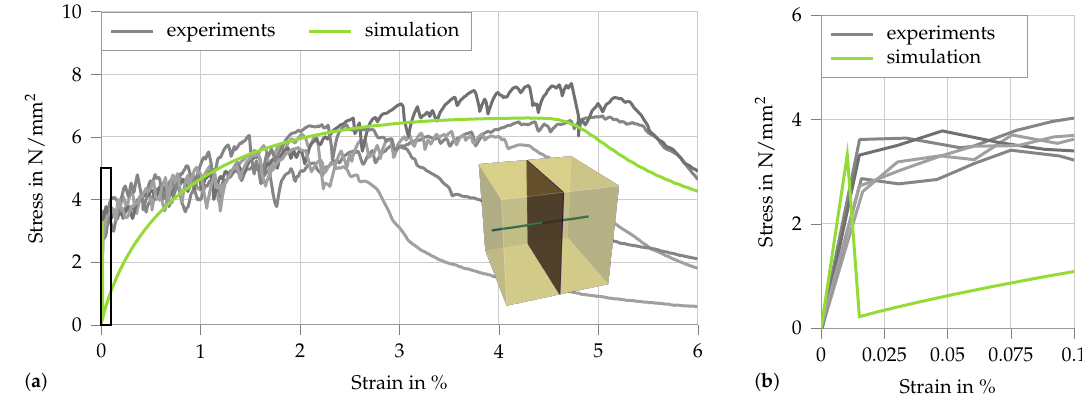
Figure 8. Results of the quasi-static multiscale simulation compared to the experimental data from [5,27]: ( a ) the loading up to 6% strain and the selected RVE; and ( b ) a zoomed-in detail of ( a ), focusing on the cracking of the matrix in the RVEs.